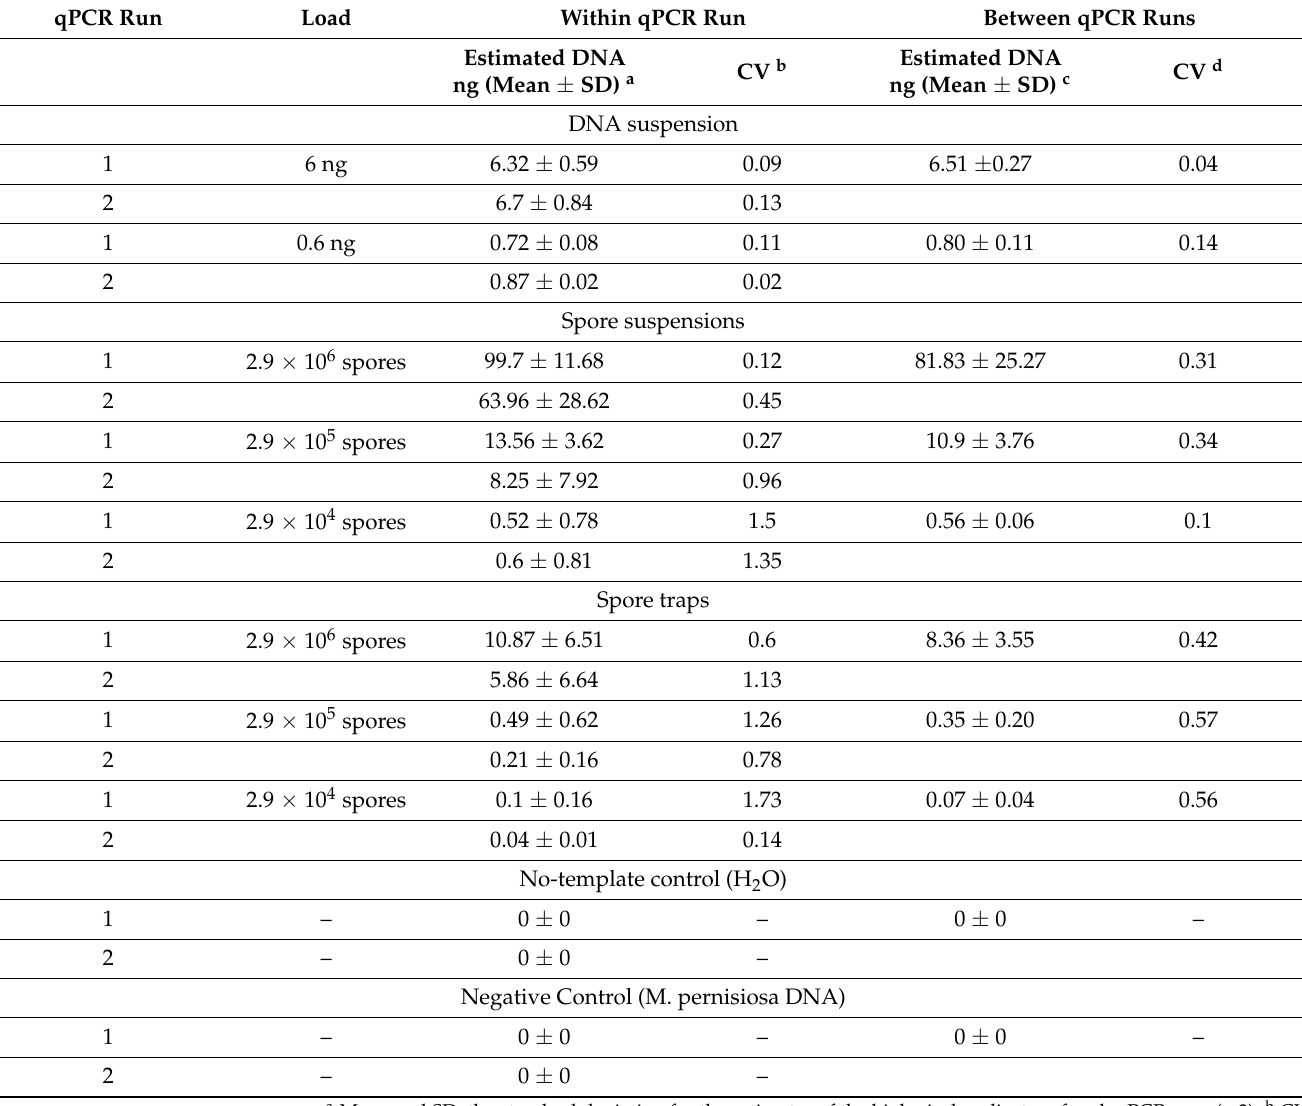
Table 2. qPCR estimates and within and between qPCR runs coefficients of variance for the Monilio- phthora roreri DNA in suspension and extracted from M. roreri spores in suspension and